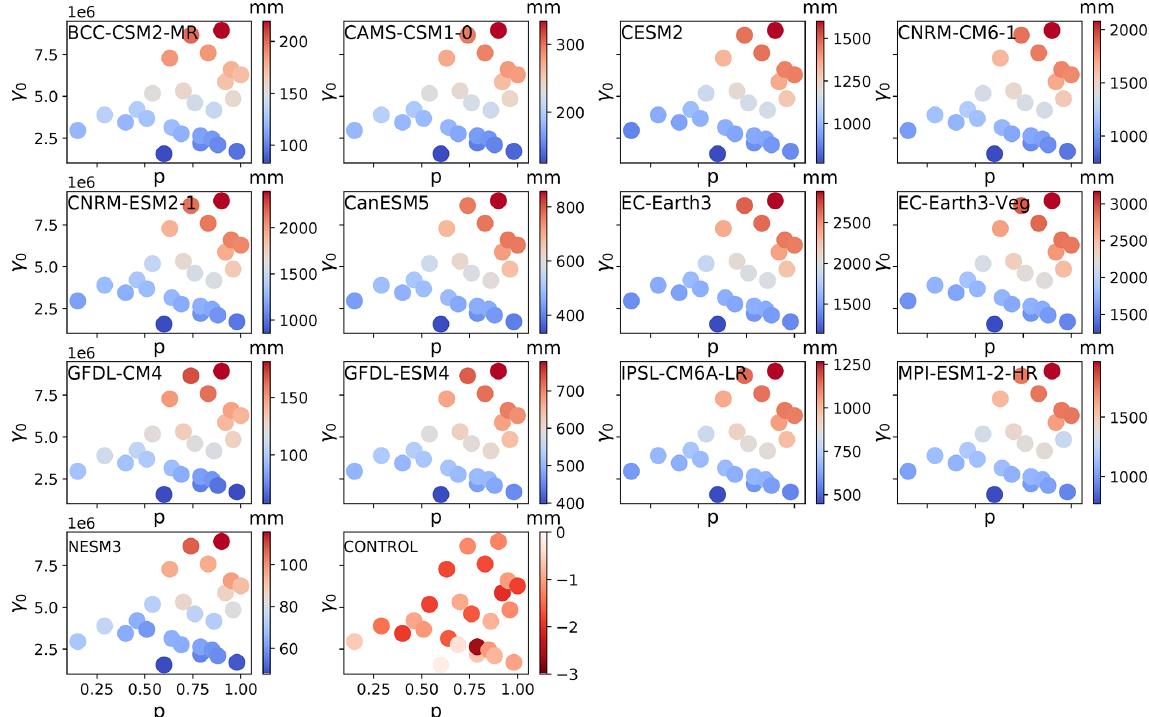
Figure 9. Final SLR for each model, γ 0 and p combination. Note the different color bar scales for each